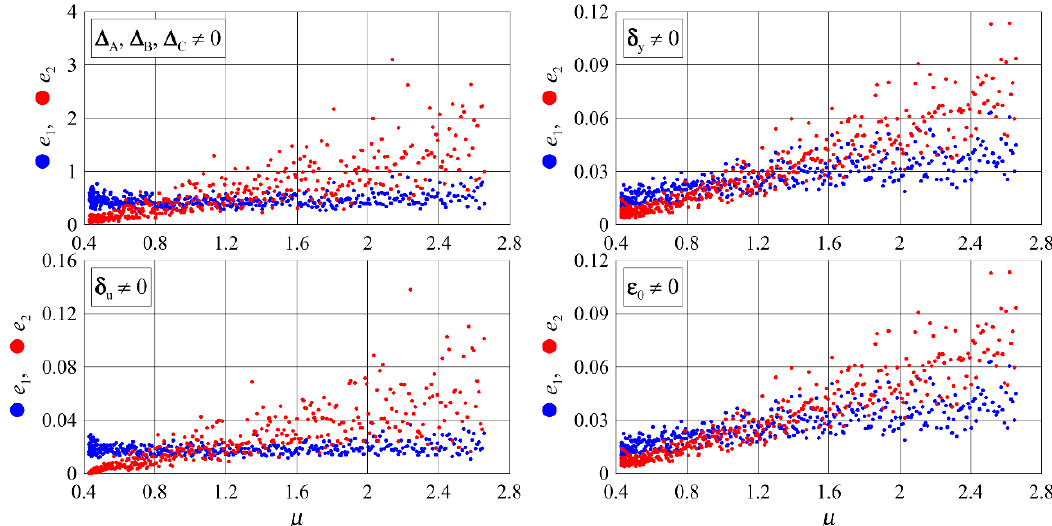
Figure 3. The dependence of the estimation errors on the amplification index.